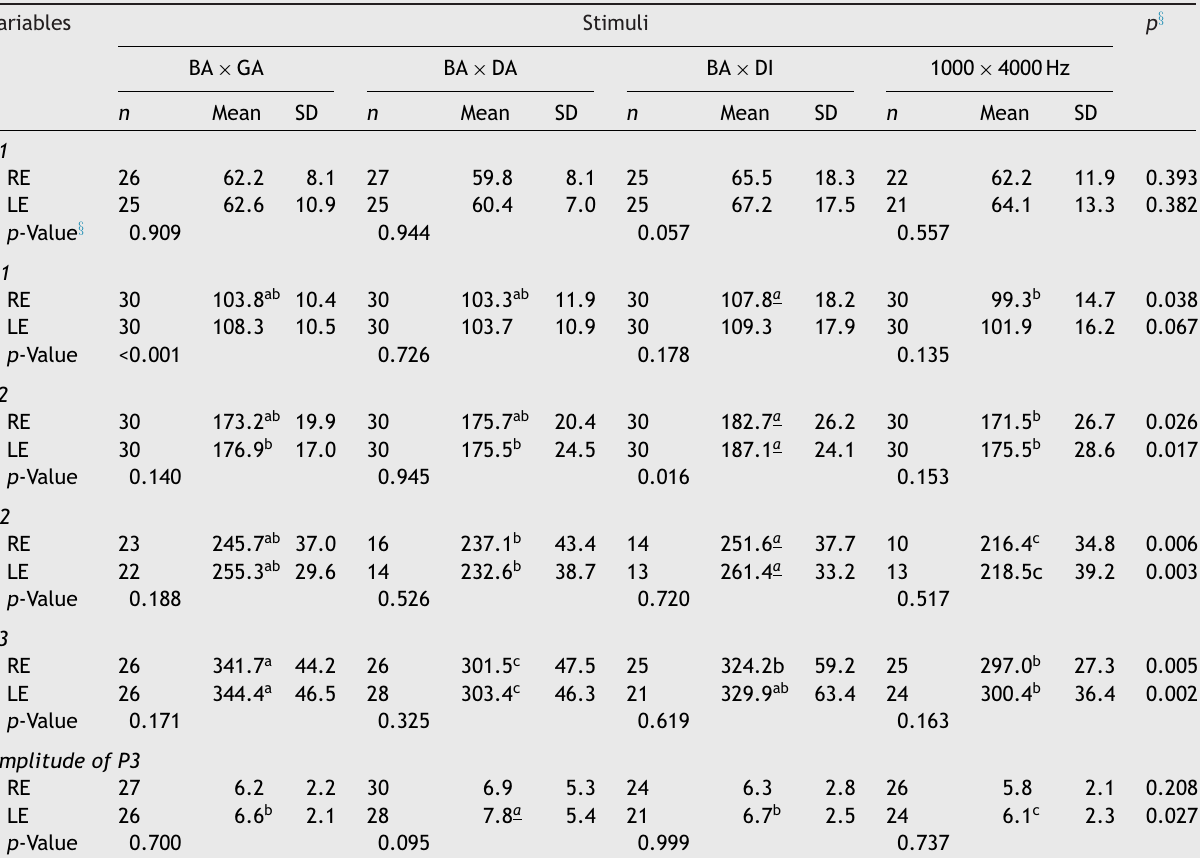
Mean and standard deviation for the P1, N1, P2, N2, and P3 components with all speech stimuli (BA-GA/BA-DA/BA-DI) and tone burst (1000 Hz × 4000